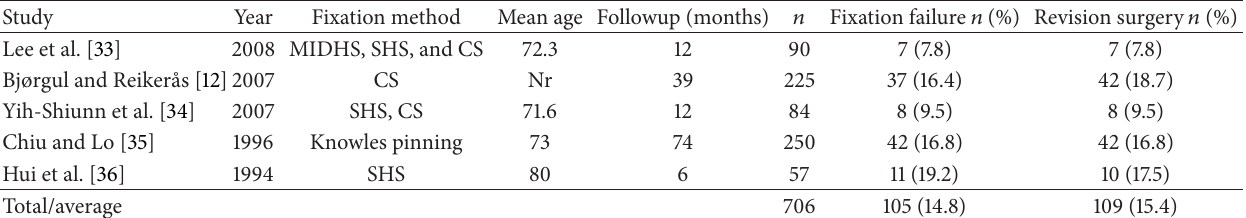
Table 1: Incidence of fixation failure and reoperation in undisplaced fractures of the femoral neck (Garden I and II). All patients > 60years. Study Year